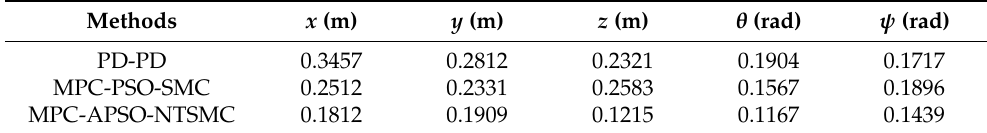
Table 7. Position MAE with random disturbance after 20 s for Case 2.